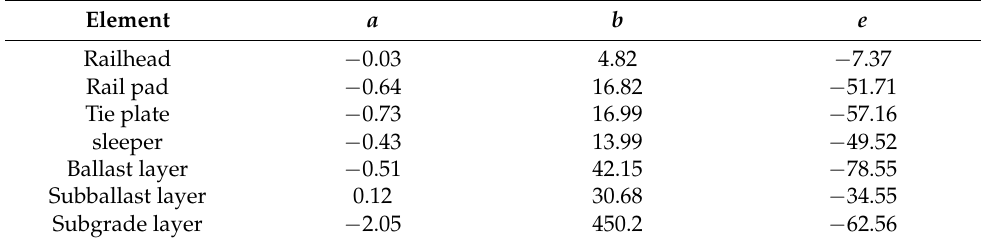
Table 6. Constant parameters for all railway track